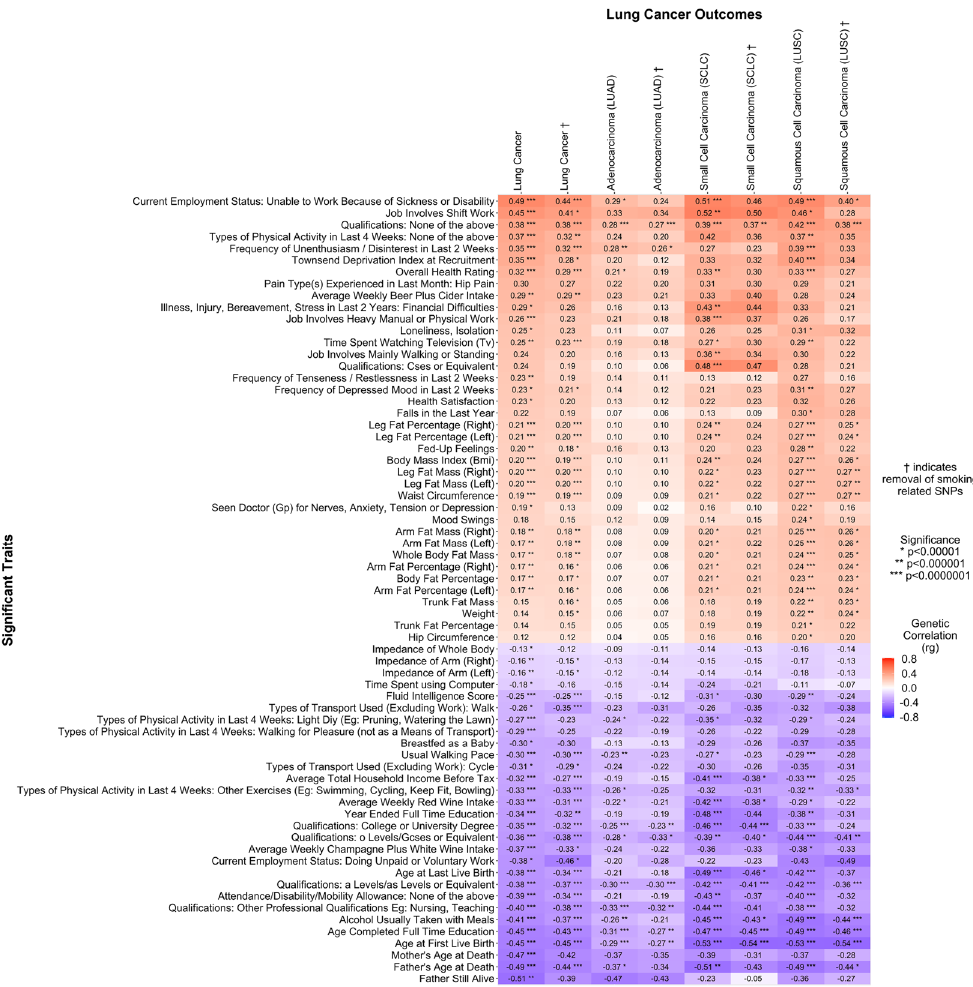
Figure 6. Genetic correlation plot of highly significant trait associations with lung cancer